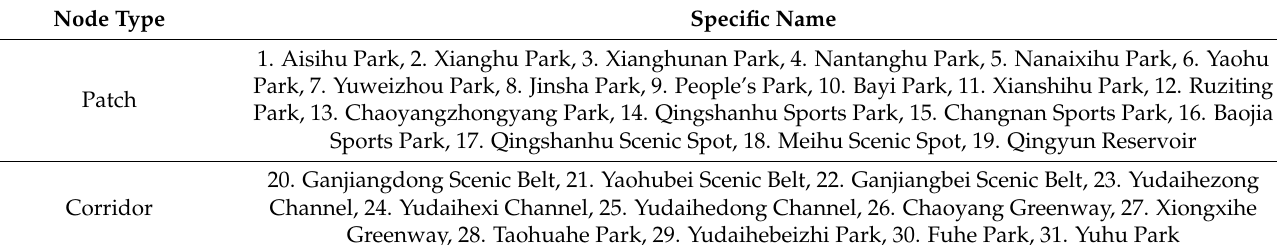
Table 1. Classification of green